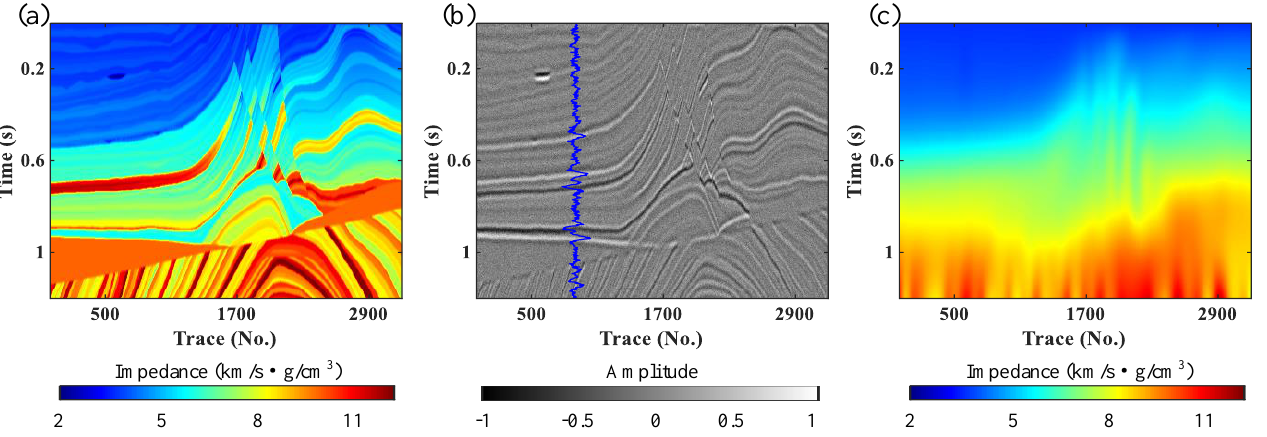
Figure 4. Synthetic data test of Marmousi model: ( a ) True impedance model. ( b ) Synthetic seismic records. ( c ) Initial impedance model.